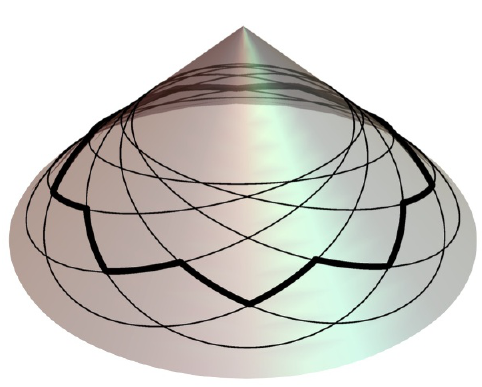
Figure 4 . Boosted circles lying on the null cone in d = 3. The vertical axis of the cone gives the time